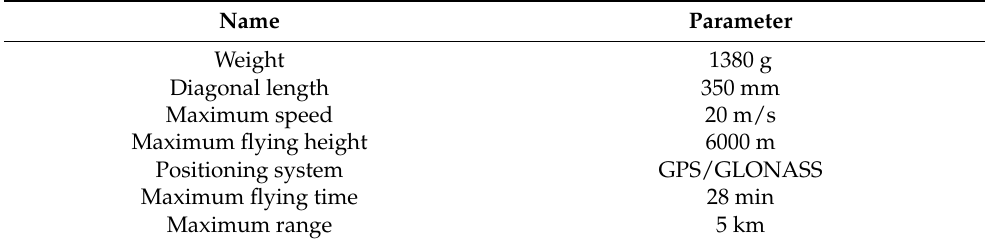
Table 1. DJI Phantom 4 main information.